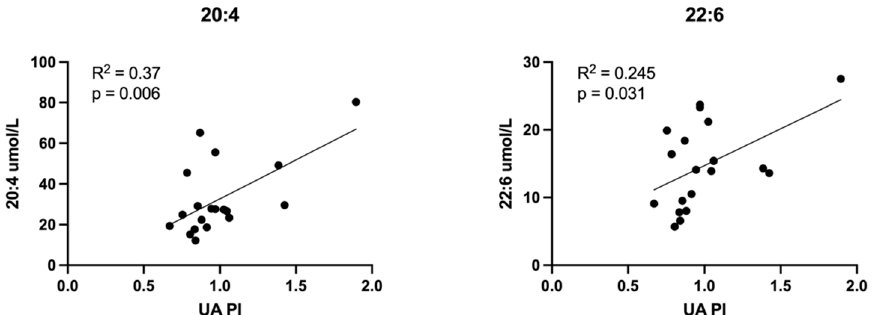
Figure 9. Correlations between umbilical vein plasma lipid concentrations and umbilical artery pulsatility index (UA PI): eicosanoids. Scatterplots demonstrate correlation relationships between UA PI and umbilical vein plasma concentrations of eicosanoid epoxyeicosatrienoic acid (EET) molecules. Pearson correlation coefficient was computed to assess relationships.